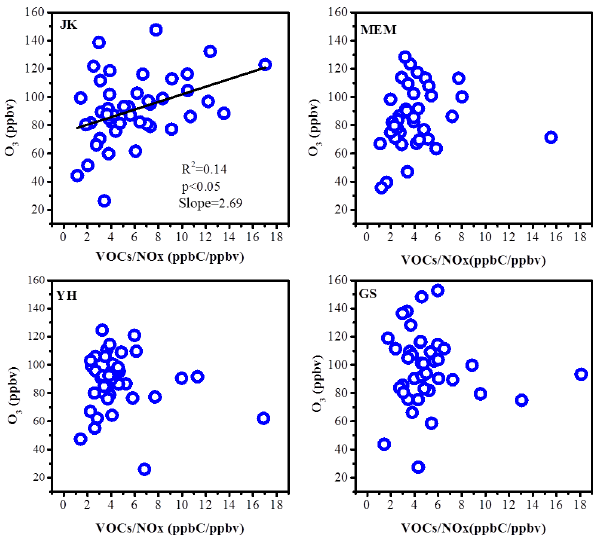
Figure 11. The relationship between O 3 and VOCs / NO x at 14:00LT for each of the four sampling